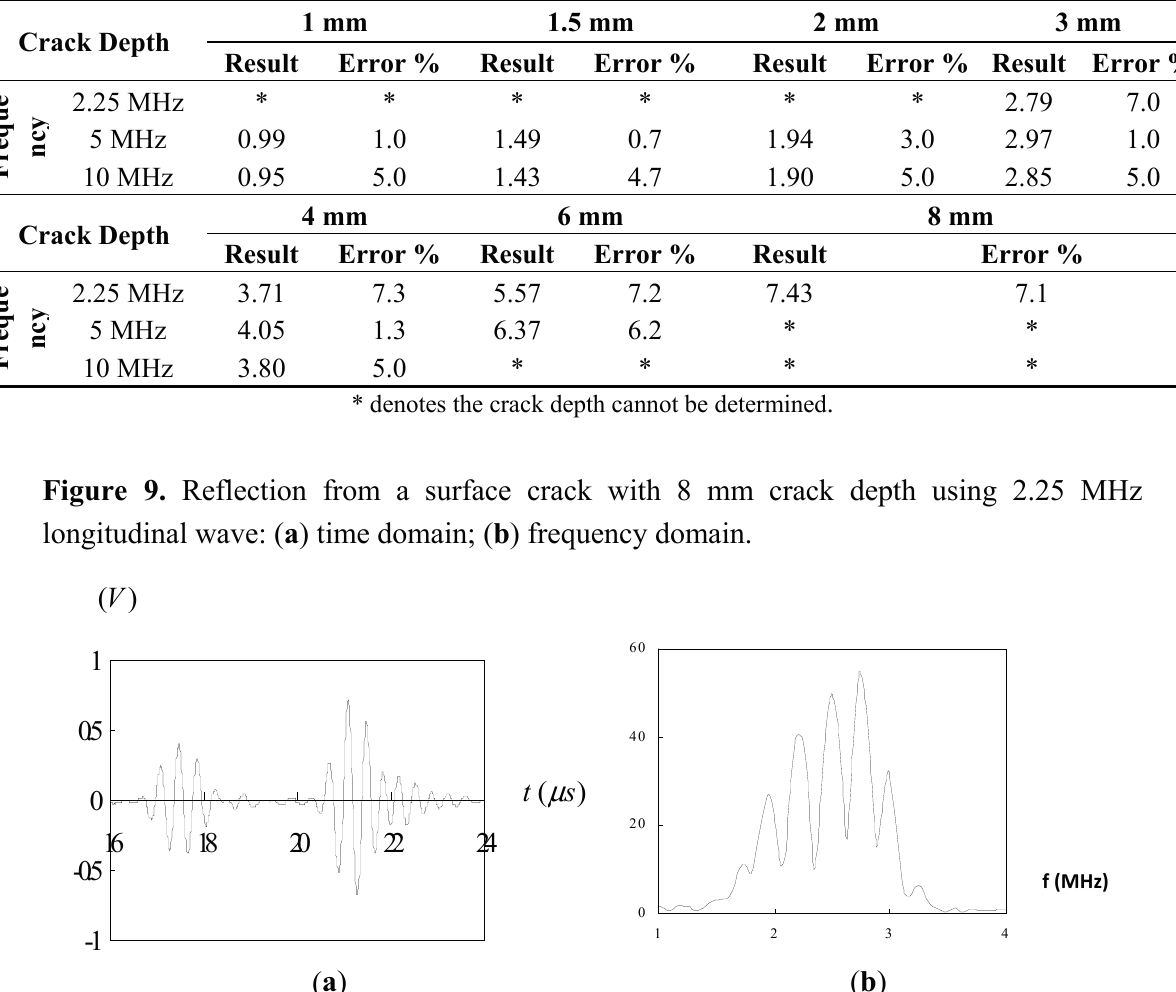
Table 1. Ultrasonic measurement results of the crack depth using three different frequencies.